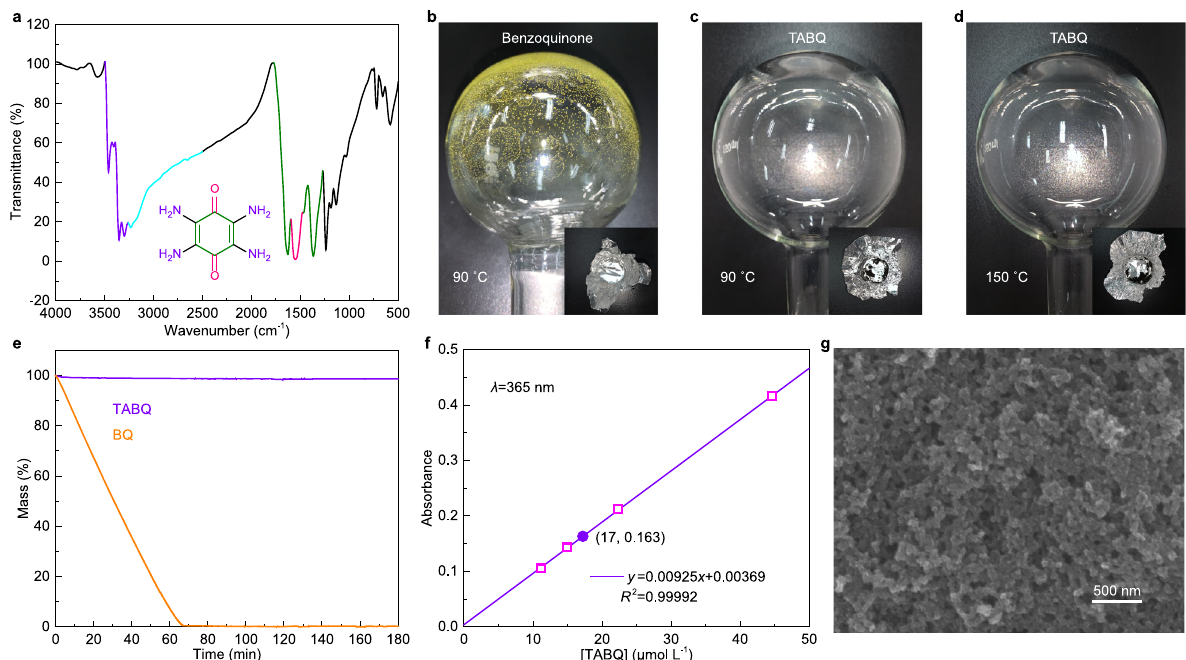
Fig. 1 Characterizations of TABQ. a FT-IR spectrum of TABQ. b , c , d Sublimation test of benzoquinone and TABQ at 90 °C and 150 °C. e TGA curves of benzoquinone and TABQ with constant temperature hold at 90 °C. f UV-vis calibration curve of TABQ in 1 M ZnSO 4 together with the calculation of the 100 times diluted saturated solution. g SEM image of the TABQ